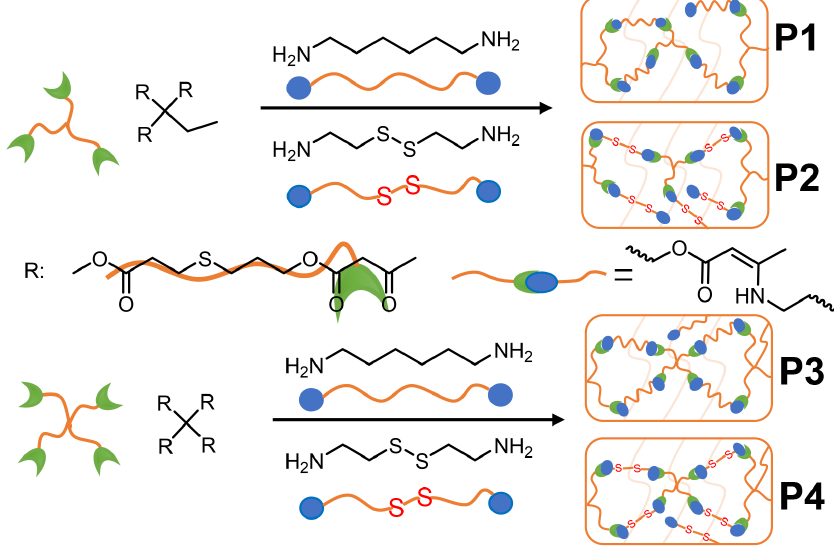
Scheme 1. Synthesis of the polymer films. Table 1. Materials for the polymer film preparation.